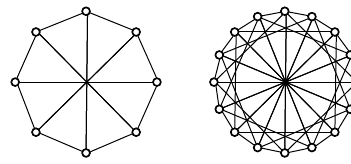
C 4 and C 16 (1, 4, 8) ∼ = K 4 (cid:49)